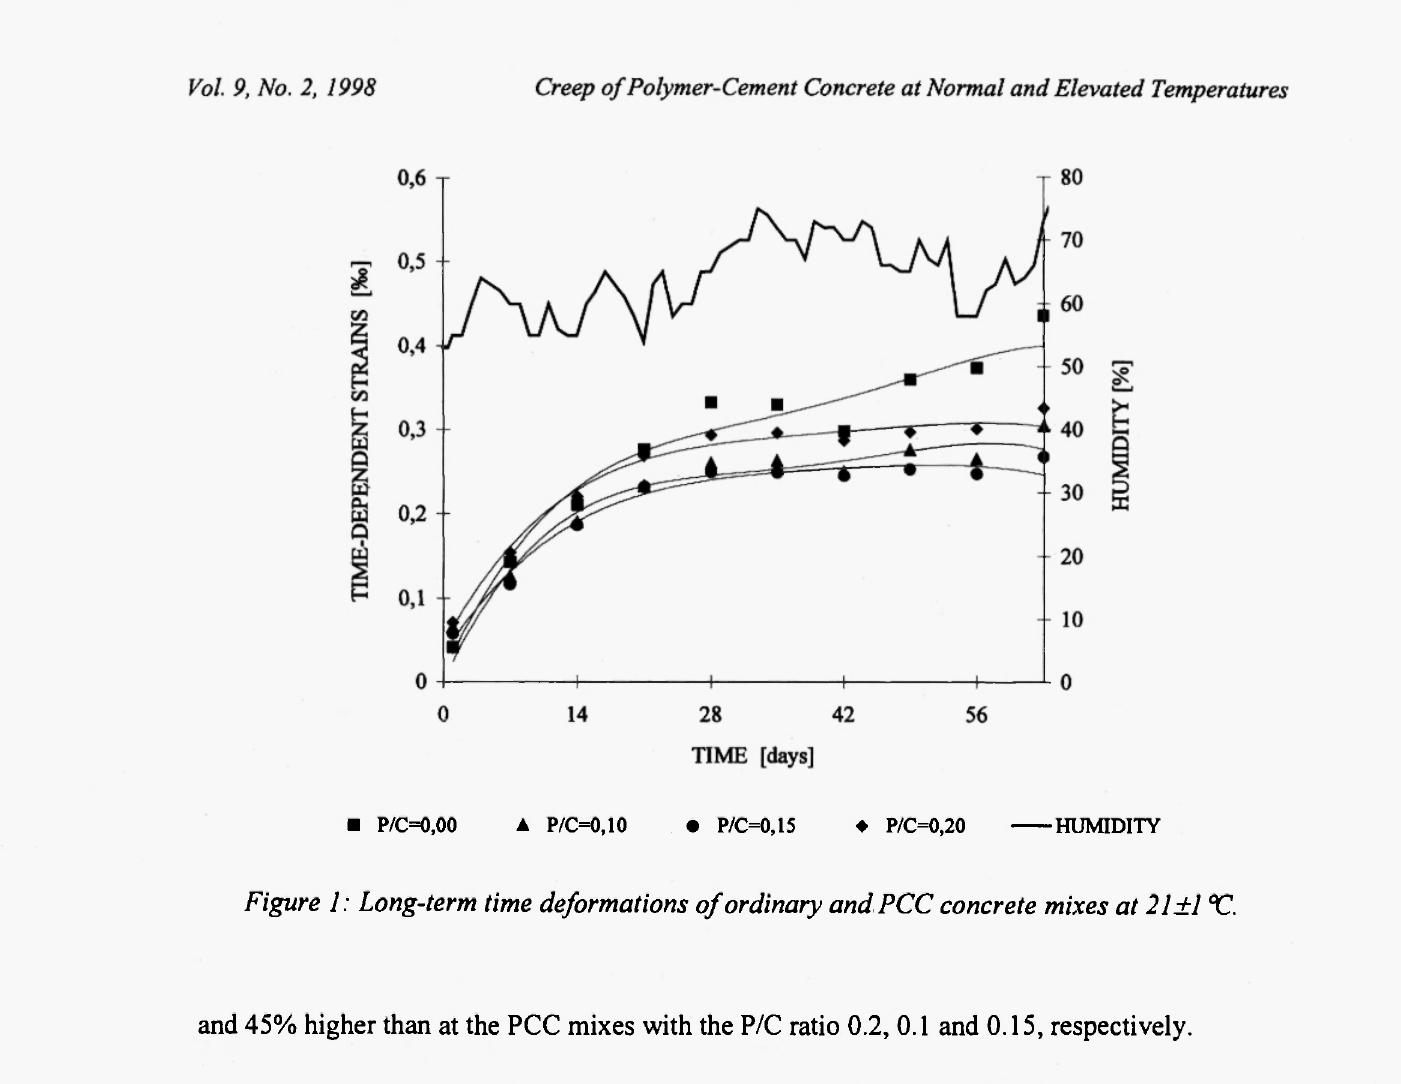
and 45% higher than at the PCC mixes with the P/C ratio 0.2, 0.1 and 0.15,